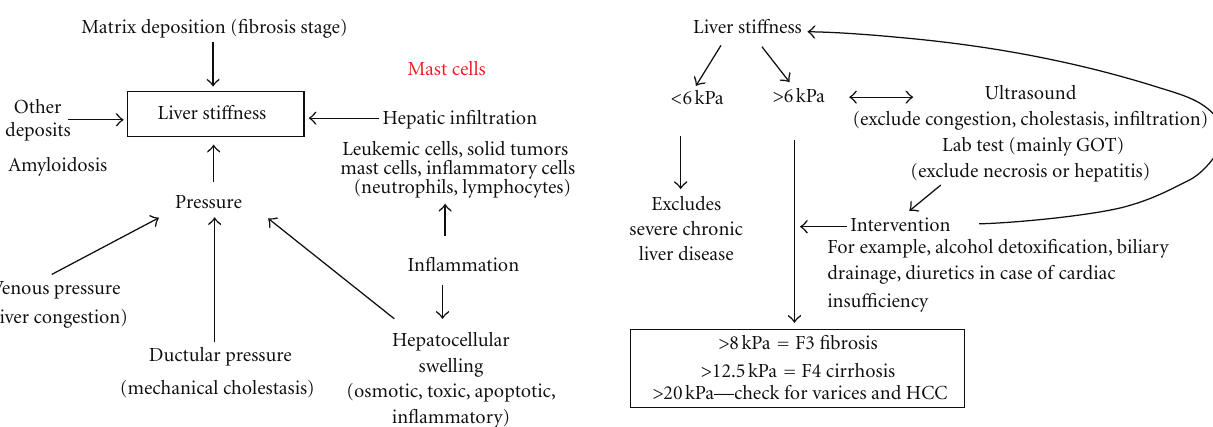
Figure 3: Factors that a ff ect liver sti ff ness including mast cell infiltration.